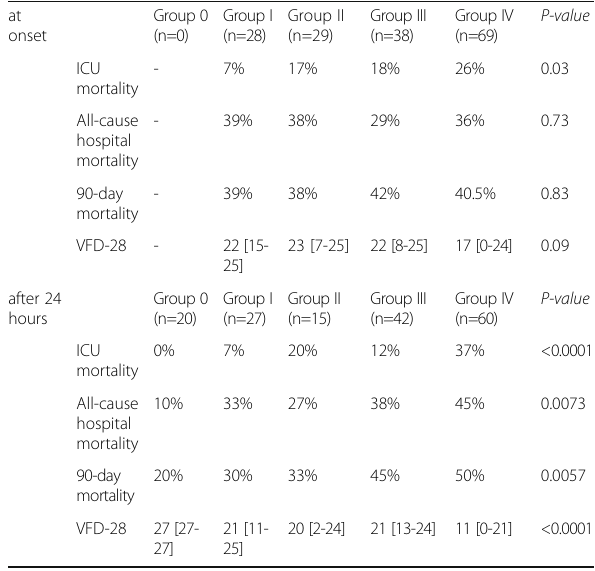
Data are medians [IQR] or percentages. P-value is p-for trend or p for linear regression Abbreviations: ARDS acute respiratory distress syndrome, VFD-28 ventilator free days and alive at day